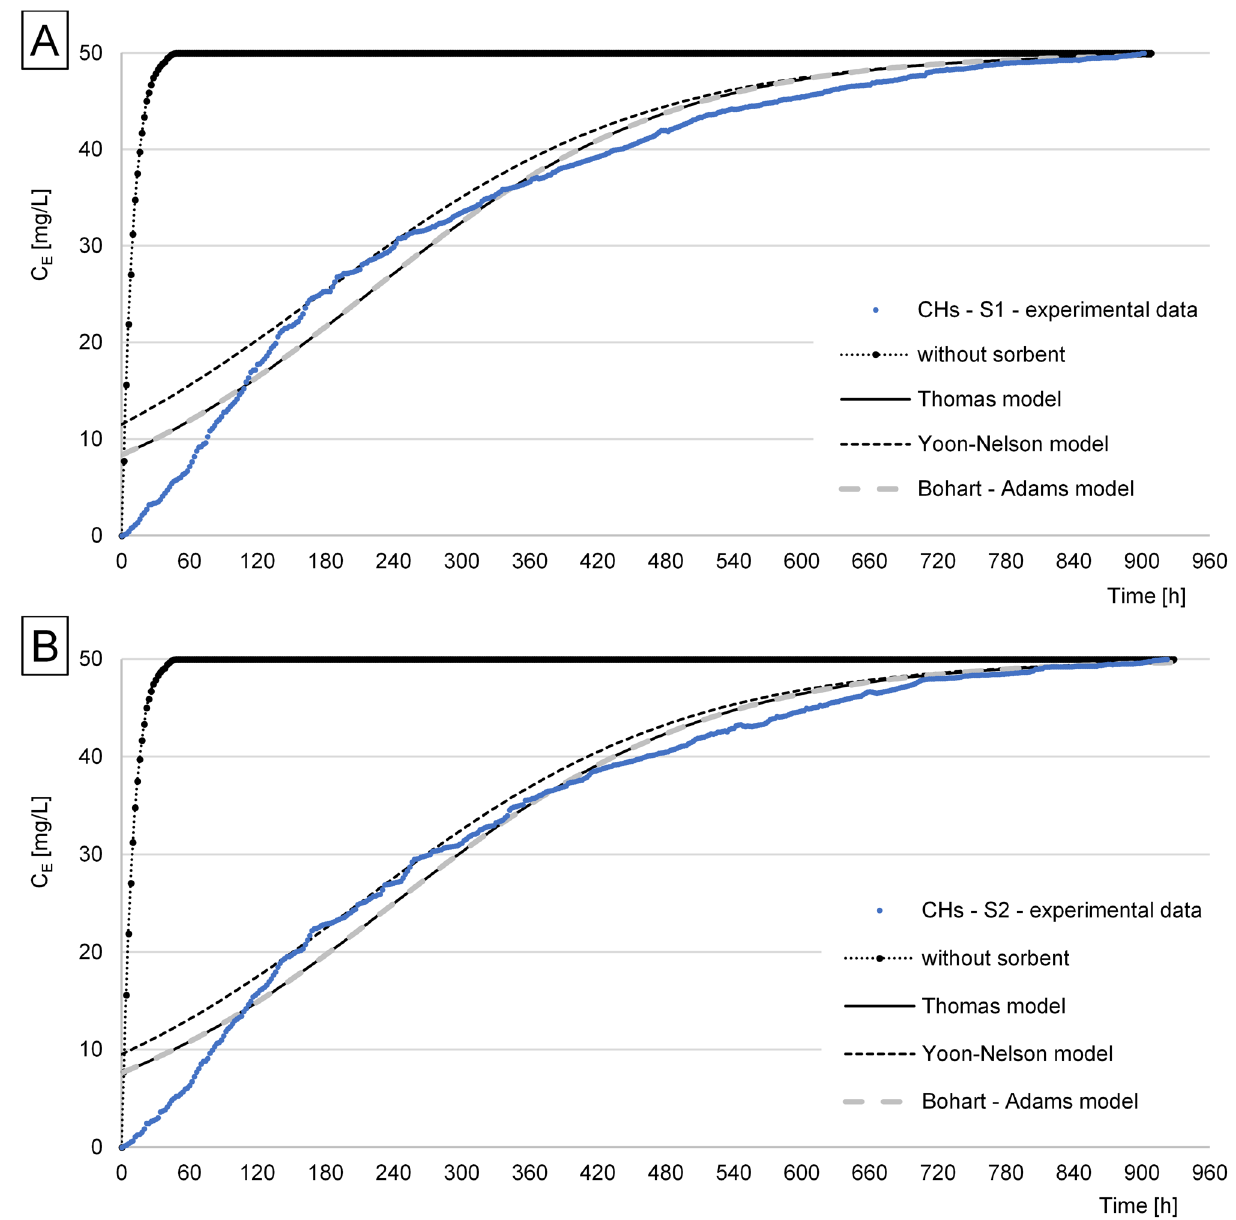
Figure 4. Concentration of RB5 at the outlet from the air-lift with a filling from CHs: ( A ) S1, ( B ) S2.